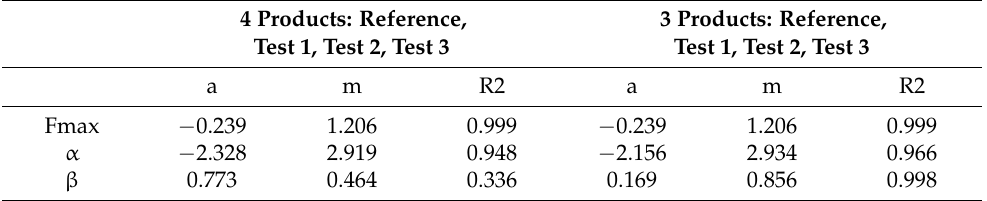
Table 6. Slope (m) and intercept (a) of the linear correlations between the in vivo and in vitro Weibull parameters obtained by curve fitting, with the fractions dissolved and fractions absorbed.